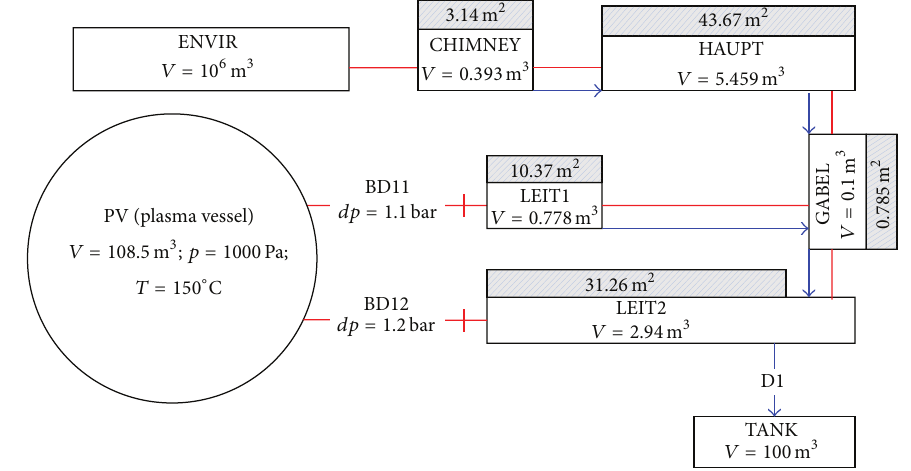
Figure 3: Nodalisation scheme of W7-X venting system for COCOSYS.